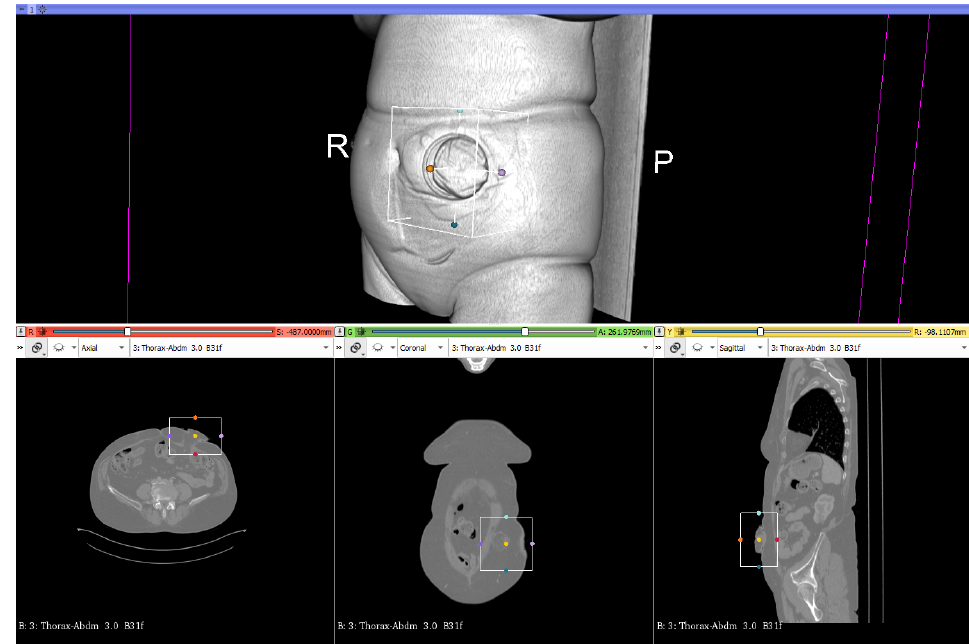
Figure 9. Selection of the stoma region in 3D Slicer.